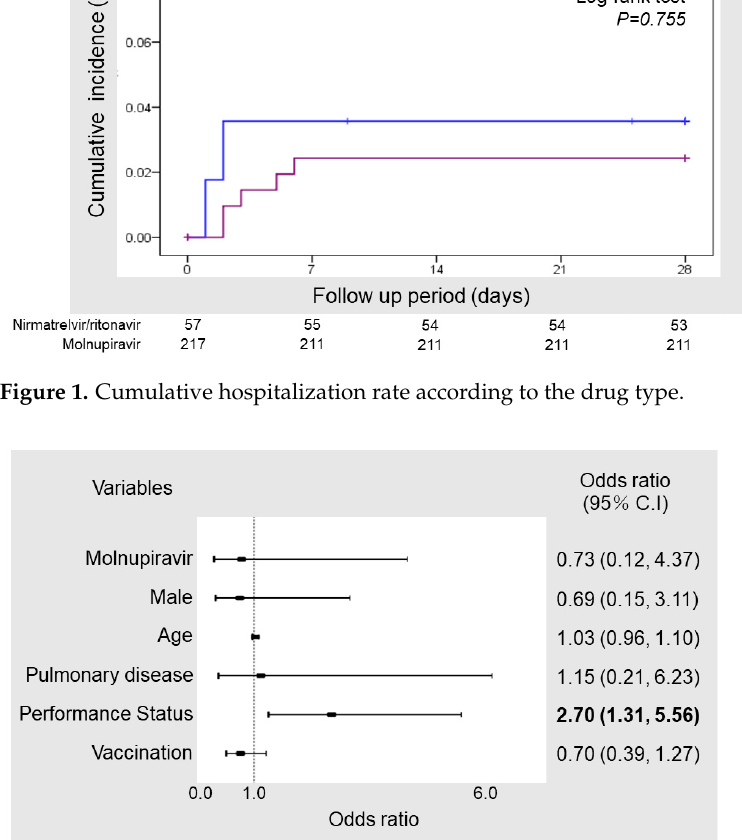
Figure 2. Forest plots of risk factors for hospitalization. Odds ratios were calculated using multivar- iable logistic regression. C.I., confidence interval.